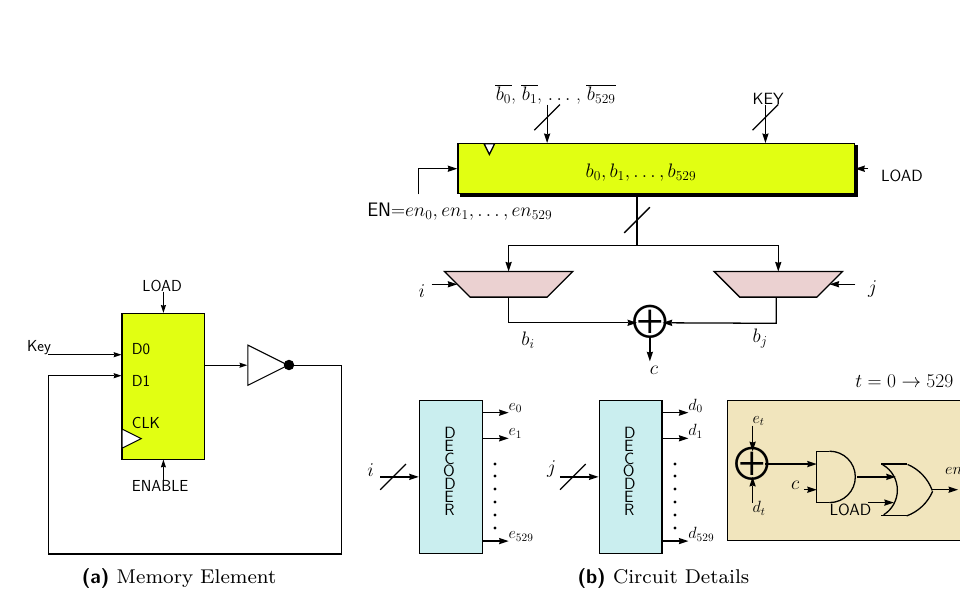
Figure 12: 3rd Circuit for